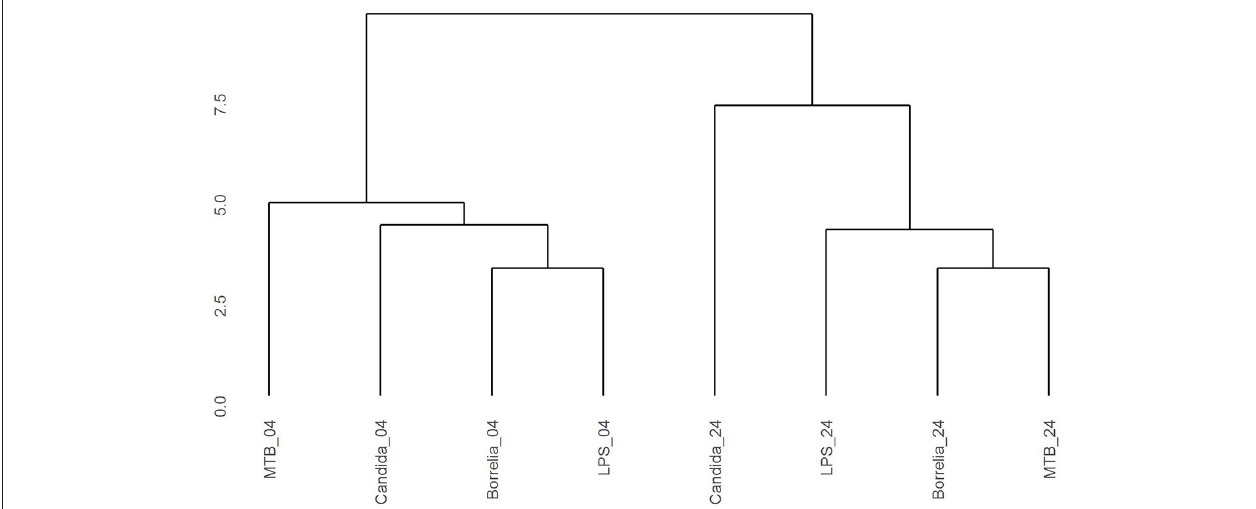
FIGURE 3 | Hierarchical clustering gene expression pattern in KEGG metabolic pathways derived from human PBMCs stimulated by Candida , Borrelia , LPS, and MTB at 4 and 24 h. Euclidean distance is calculated to quantify similarity between two metabolic pathway gene expression